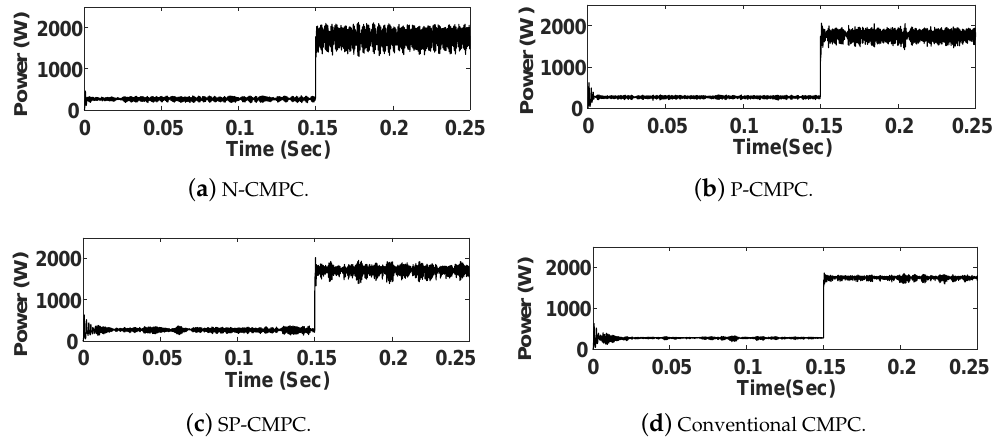
( d ) Conventional CMPC. Figure 18. Dynamic response of active power using frequency control methodologies with the conventional CF (CMPC). ( a ) Notch filter control using the conventional CF (N-CMPC) ; ( b ) periodic control using the conventional CF (P-CMPC); ( c ) simple penalization control using the conventional CF (SP-CMPC); and ( d ) conventional CF